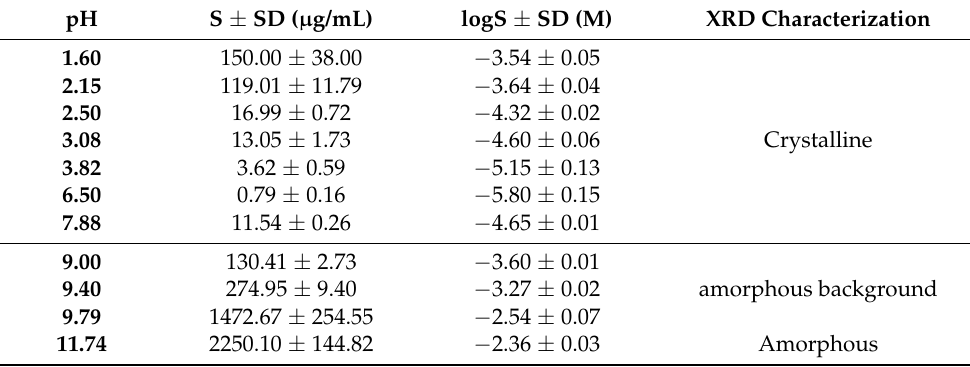
Table 2. Equilibrium solubility of Telmisartan in Prisma HT buffer.